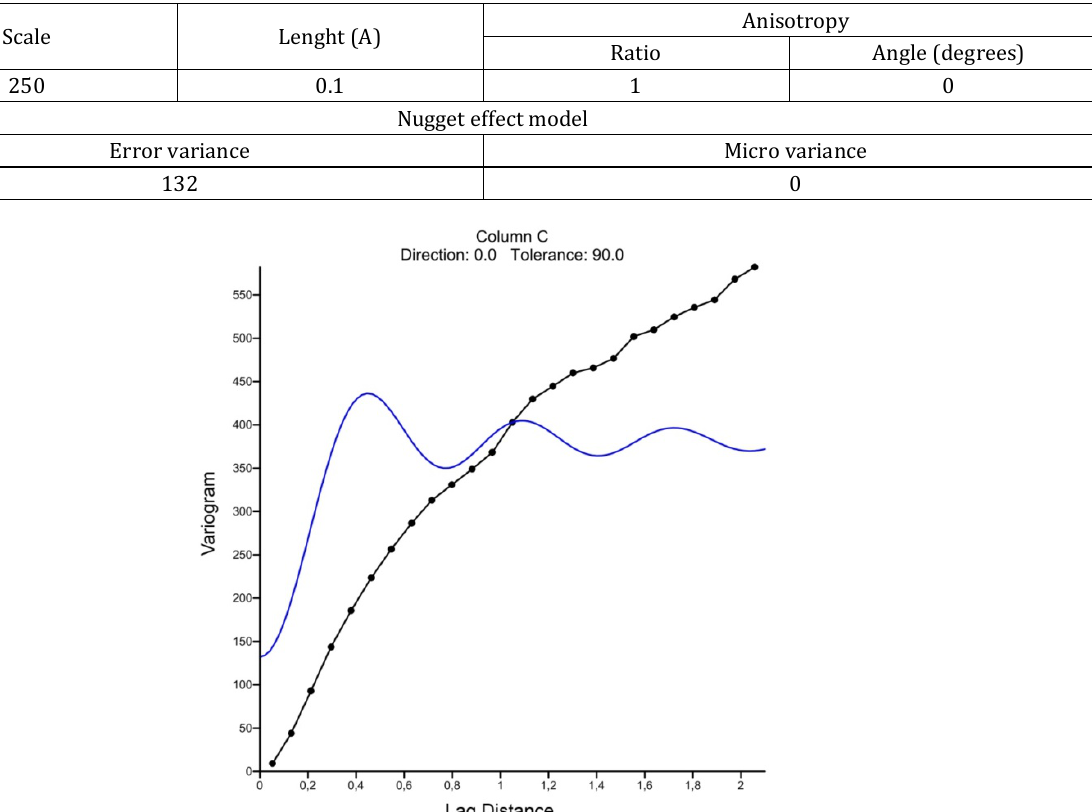
Table 3. Parameters of theoretical models deliberately unadjusted with the empirical variogram